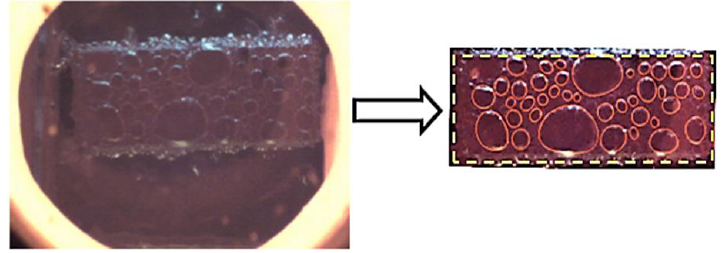
Figure 3. Image before and after image processing.